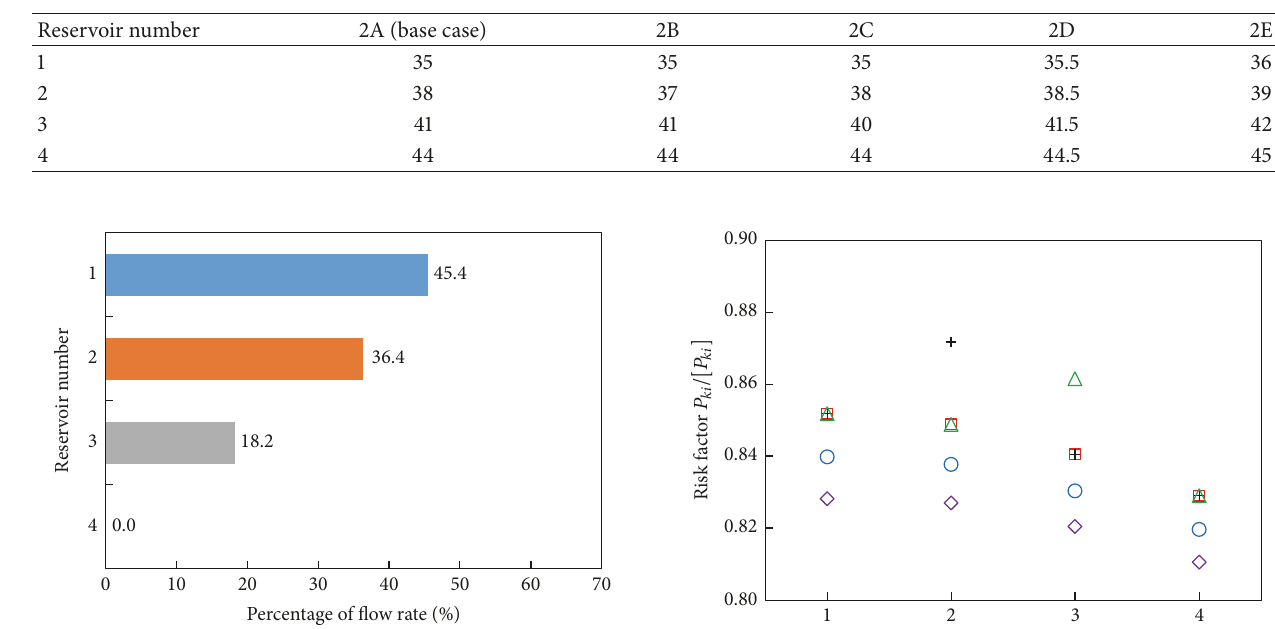
Table 4: Cases with different formation-fracturing pressures (MPa).